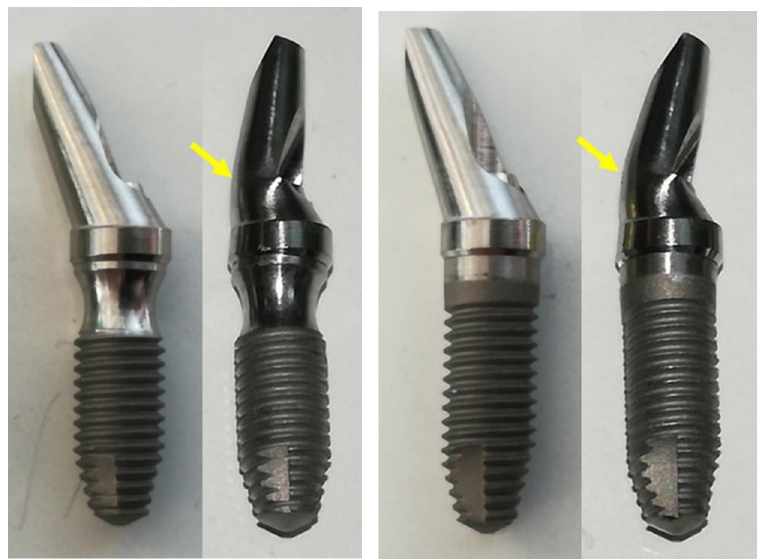
Fig 7. Representative images of a sample before (left) and after (right) the load application of the Collo bl group (a) and EH con group (b). The yellow arrows indicate the points where the set showed less resistance.